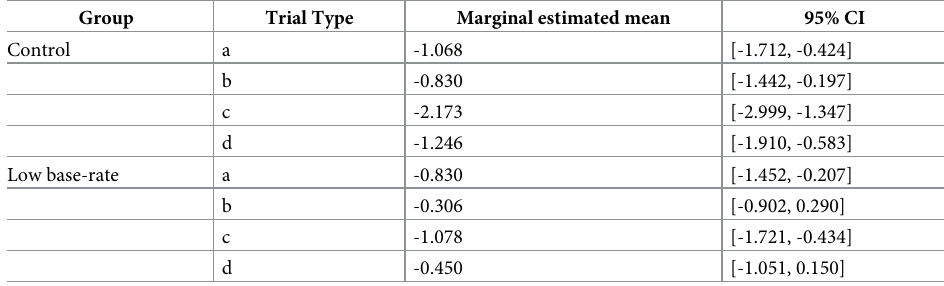
Table 6. Evidential value questions in Experiment 2: Marginal estimated means (logit